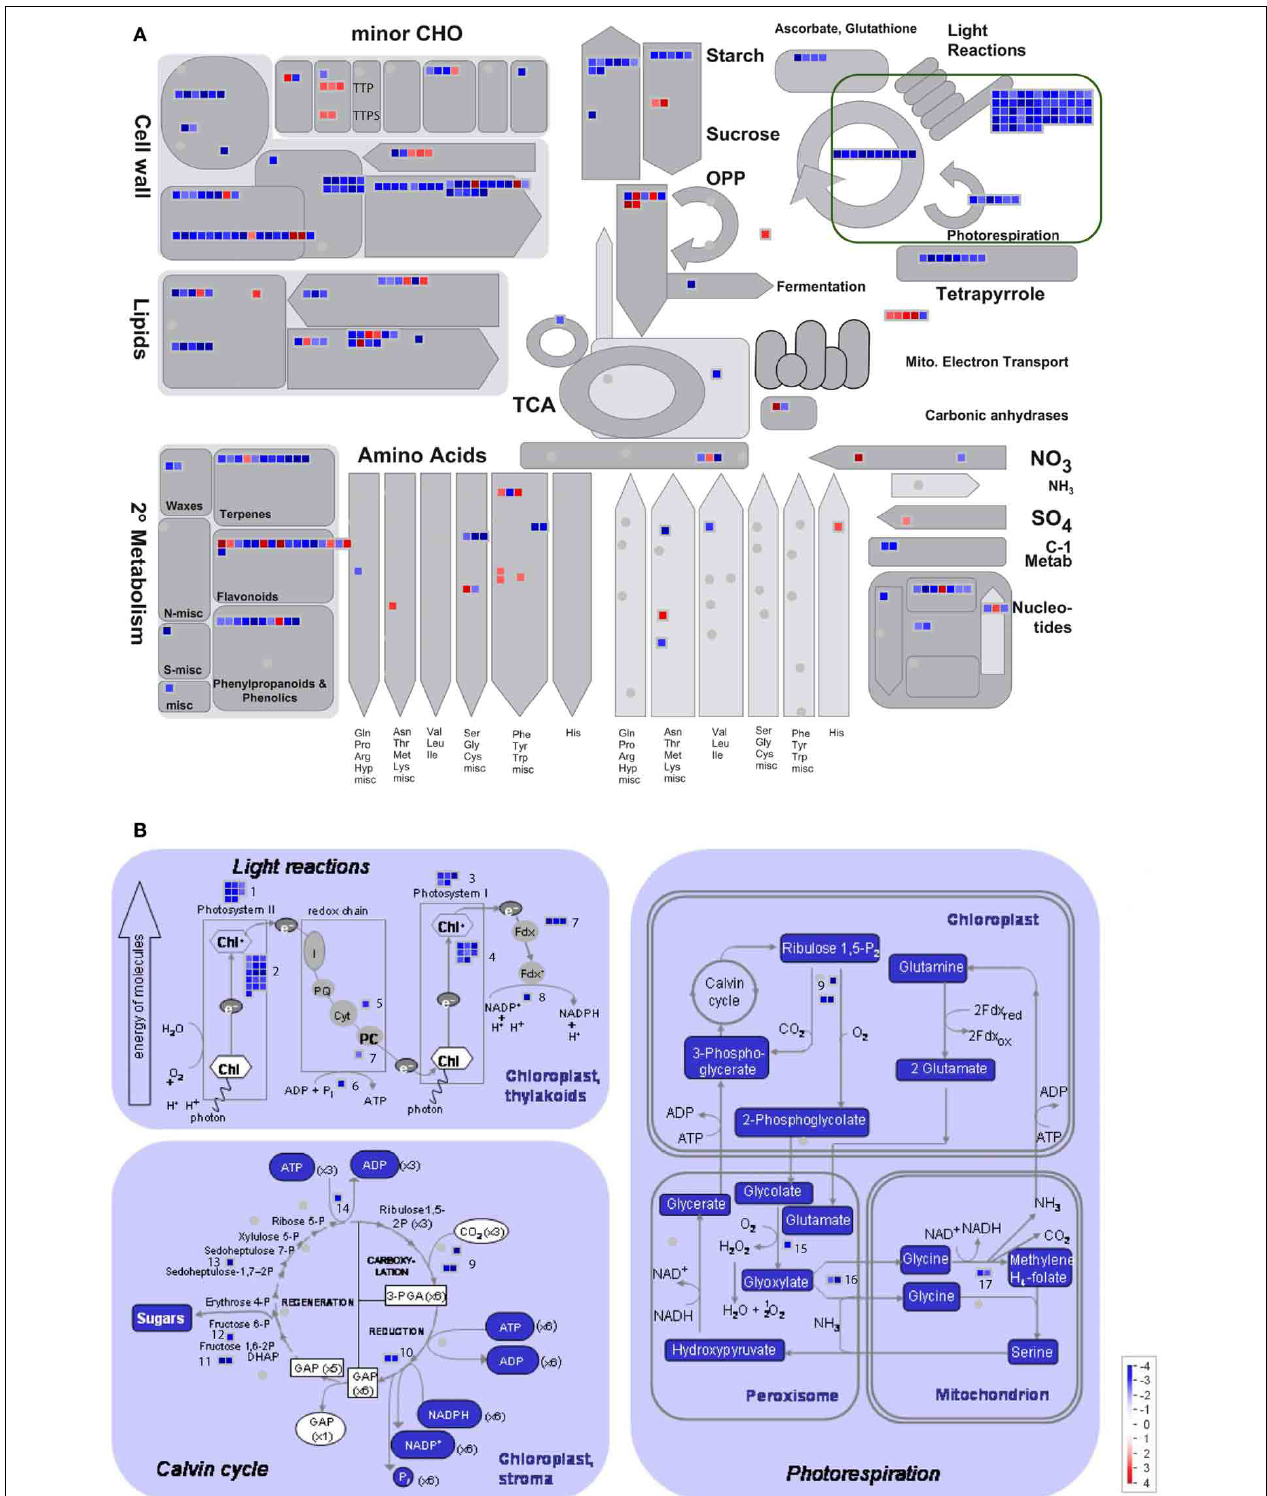
FIGURE 4 | MapMan pathway overview analysis of DEG. (A) Overview of MGAT1 effect on transcripts related to different pathways generated by “Metabolism overview” analysis in MapMan. Fold changes (Log2) are indicated by the colour scale. Distribution of transcripts into different pathways and their expression trend in each pathway is illustrated.